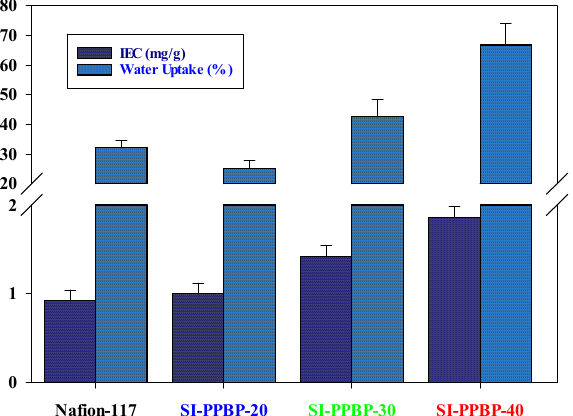
Figure 3. Ion exchange capacity (IEC) and water uptake (WU) for the SI-branched PPBP